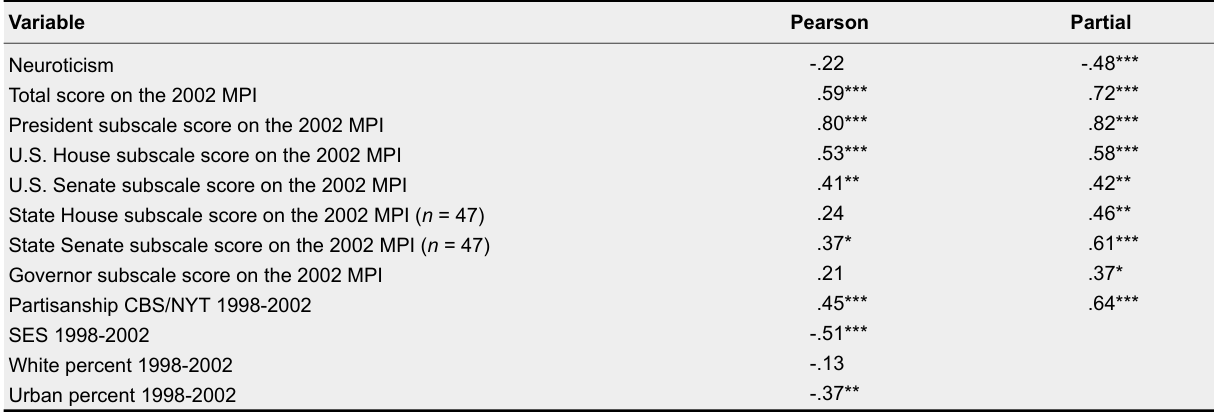
Pearson Correlations between CBS/NYT 1998-2002 State Ideology and 12 other Variables, and Corresponding Partial Correlations with State SES, White Percent, and Urban Percent Controlled (N = 48) PartialPearsonVariable